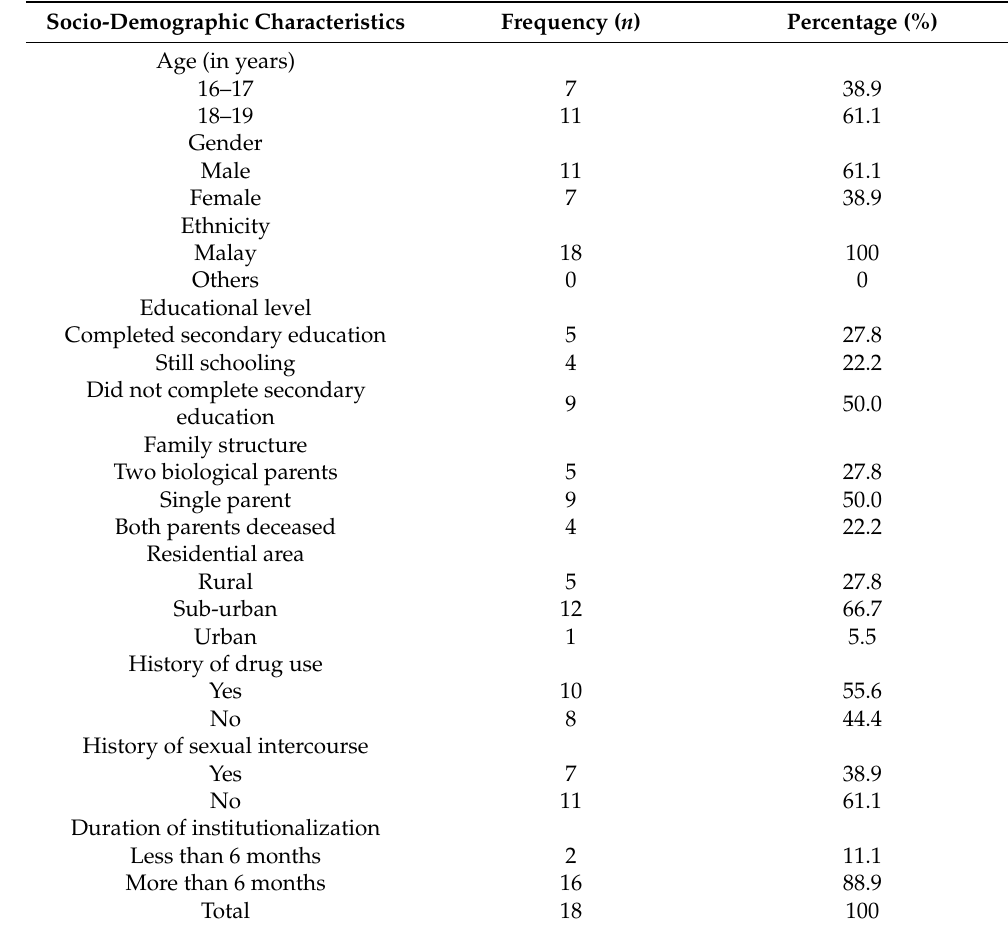
Table 1. Socio-demographic Characteristics of